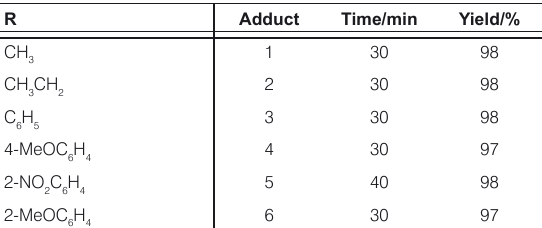
Scheme 1. Diels-Alder reaction of anthrone with maleimides under neutral Table 1. Ionic liquid-catalyzed Diels-Alder reaction, yields obtained for adducts 1-6 .